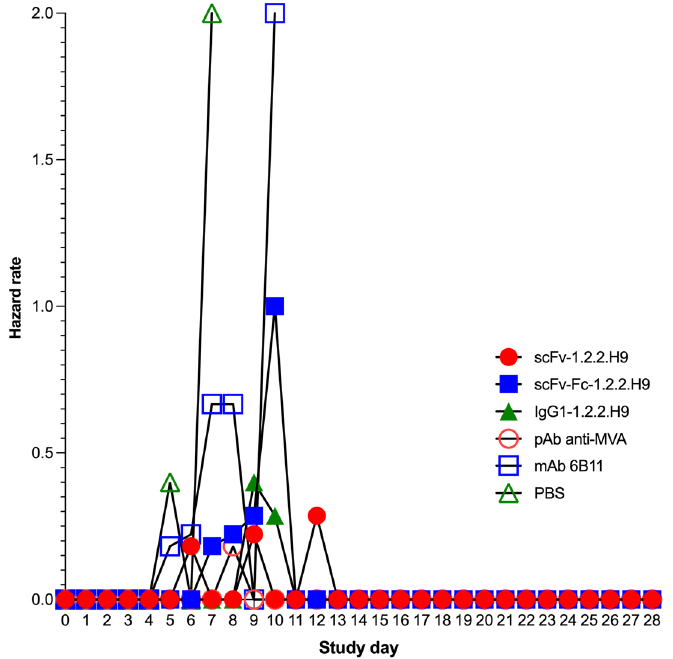
Figure 11. Hazard function for different treatment groups during the in vivo passive immunization. Of the mice receiving the scFv-1.2.2.H9 (group 1), three were protected and three were sacrificed at day 7, 10, and 11 post-challenge. Five out of six mice receiving scFv-Fc-1.2.2.H9 (group 2) were sacrificed between 8 and 11 days post-challenge. Three mice of the IgG1-1.2.2.H9 group (group 3) were sacrificed on days 10 and 11. One animal was sacrificed in the pAb anti-MVA positive control group (group 4) on day 9; the remaining animals survived the challenge until termination of the experiment on day 28. All animals of the two negative control groups (anti-EHV1 6B11 mAb and PBS, groups 5 and 6) were sacrificed between day 6 and 11. The higher survival rate resulted in a lower hazard rate at certain time points. The group treated with mAb 6B11 has a lower survival rate at a very early stage of infection, which is reflected in a high hazard rate in the period between 6 and 8 days post-infection. The same is more or less true for the PBS